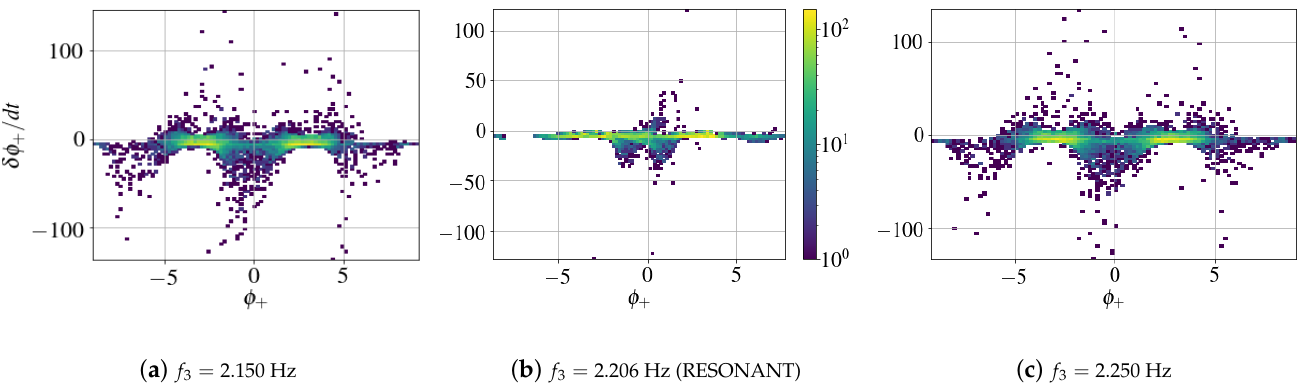
( t ) , over the simulation time dt